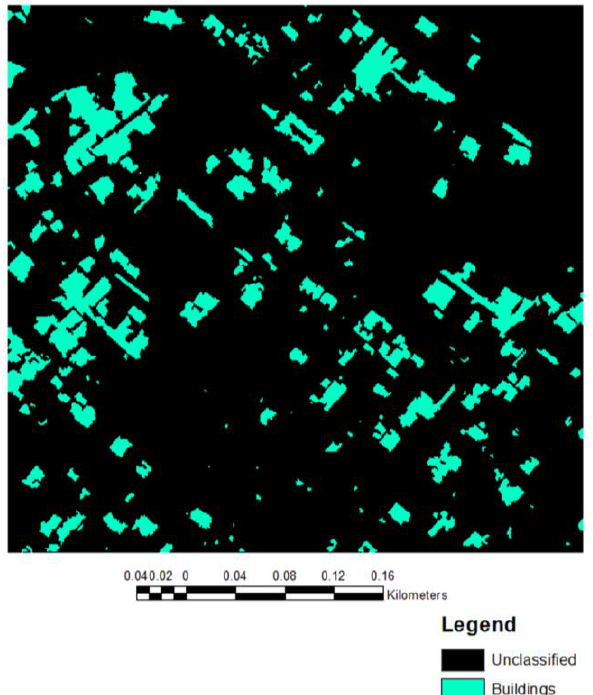
Figure 9 Extracted buildings using Rule based feature extraction algorithm